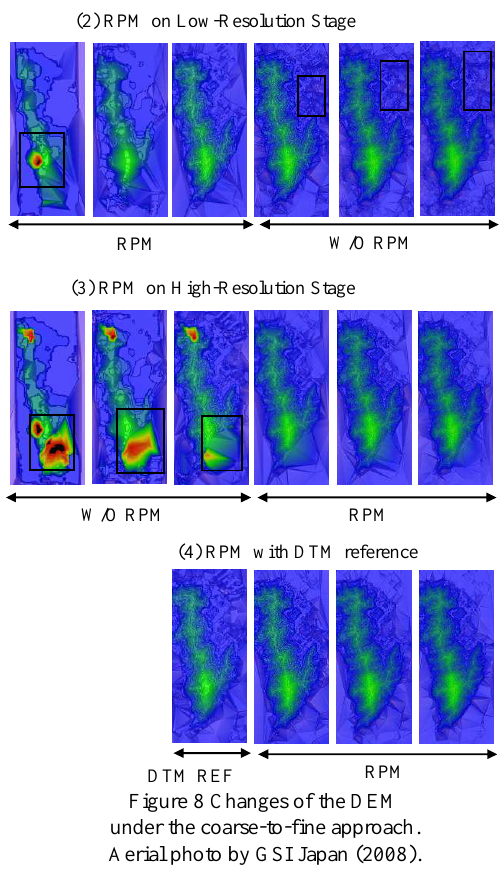
Figure 8 Changes of the DEM under the coarse-to-fine approach. Aerial photo by GSI Japan